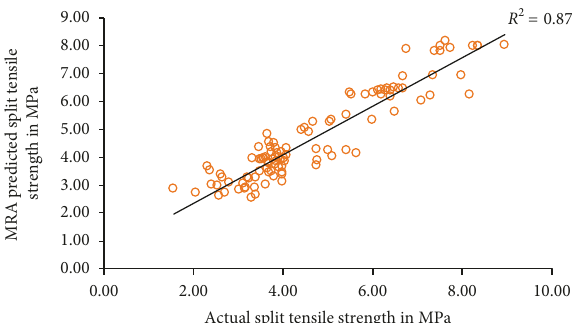
Figure 3: Actual vs. MRA predicted value for split tensile strength.